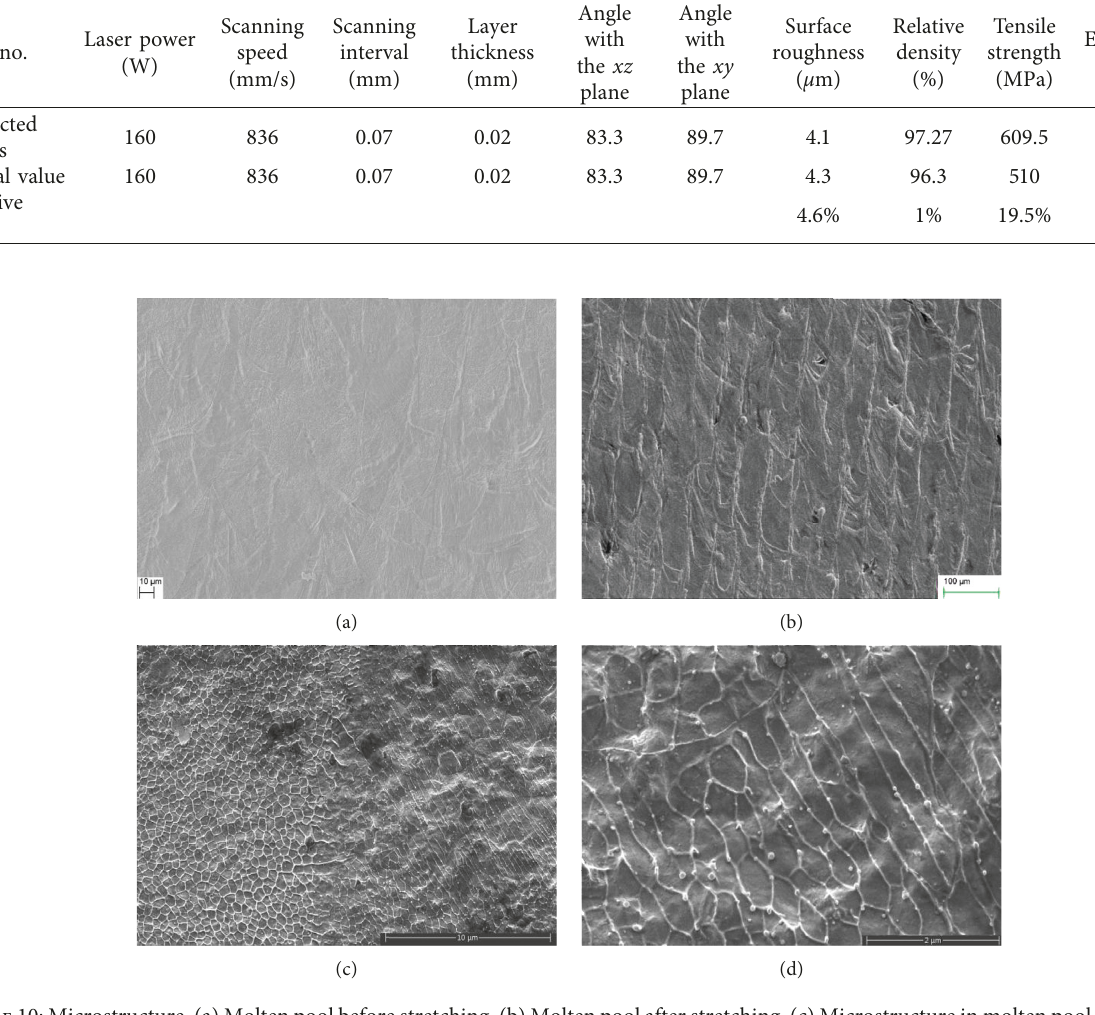
Figure 10: Microstructure. (a) Molten pool before stretching. (b) Molten pool after stretching. (c) Microstructure in molten pool. (d) Partial enlargement of microstructure in molten pool.